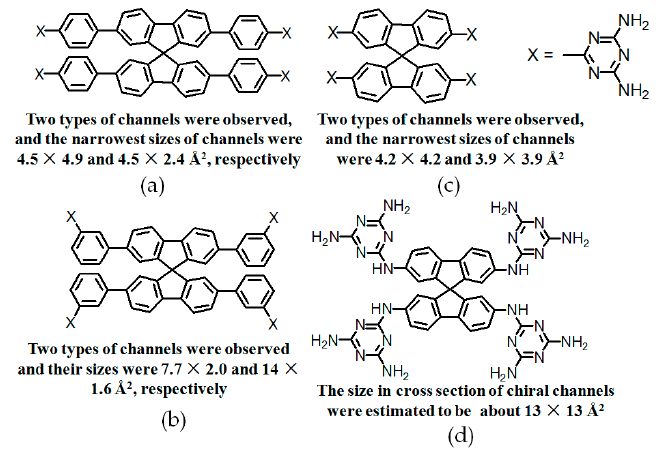
Figure 24. Structures of building motifs 27a ( a ); 27b ( b ); 27c ( c ); and 27d ( d ).